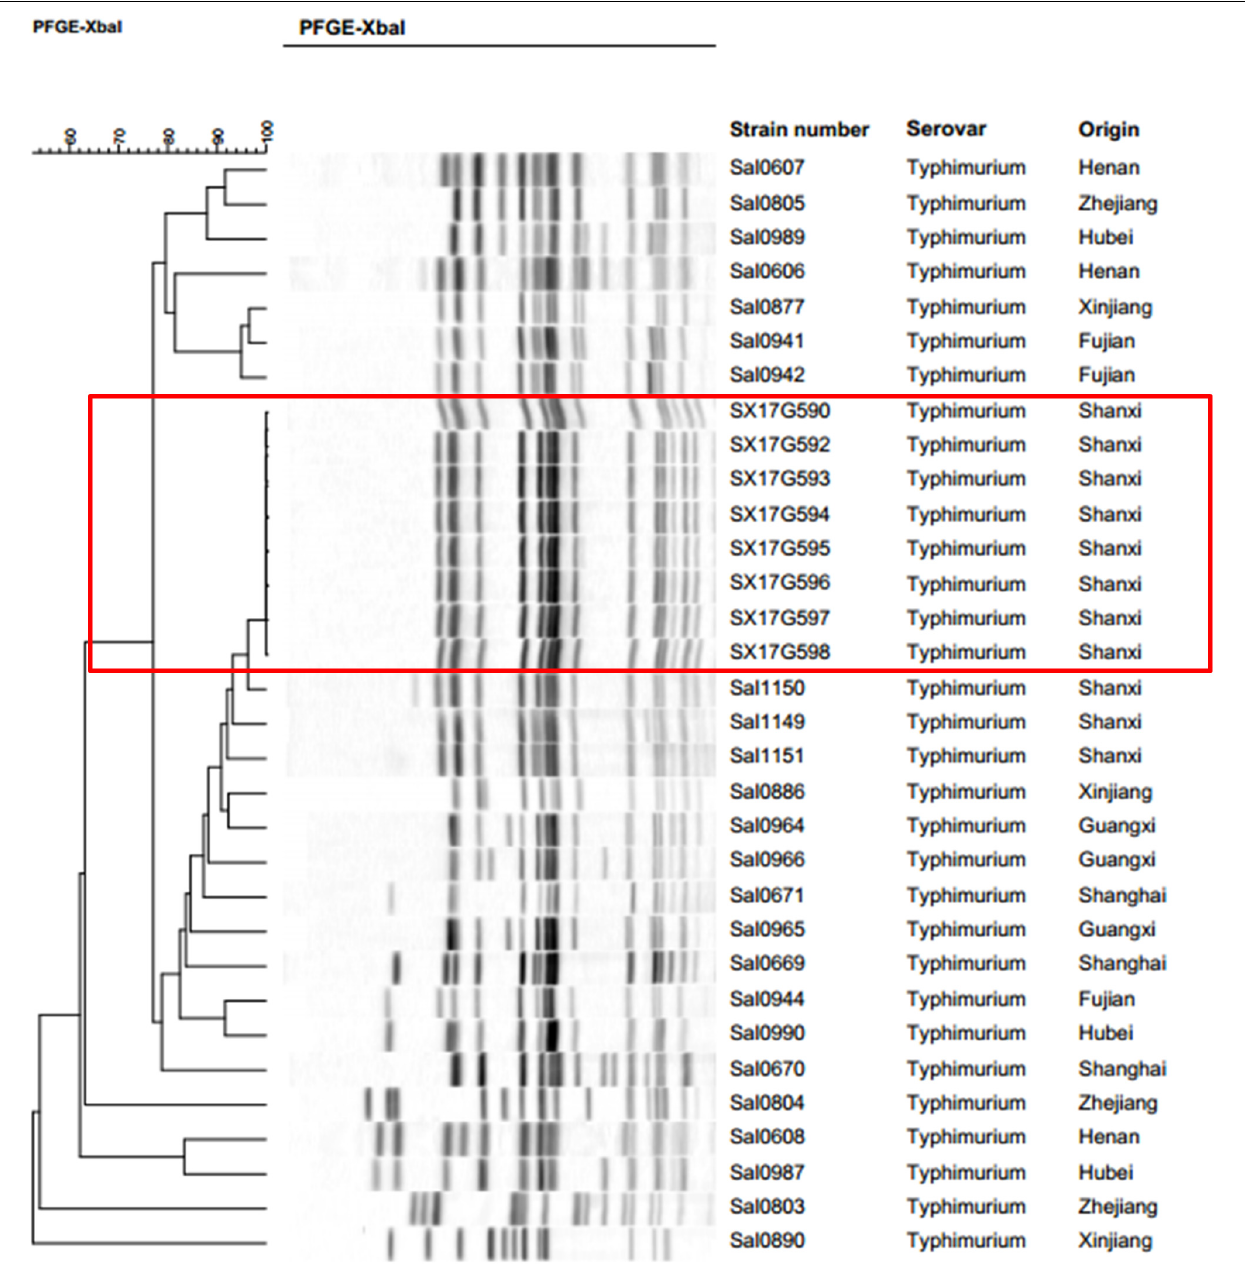
Frontiers in Microbiology |